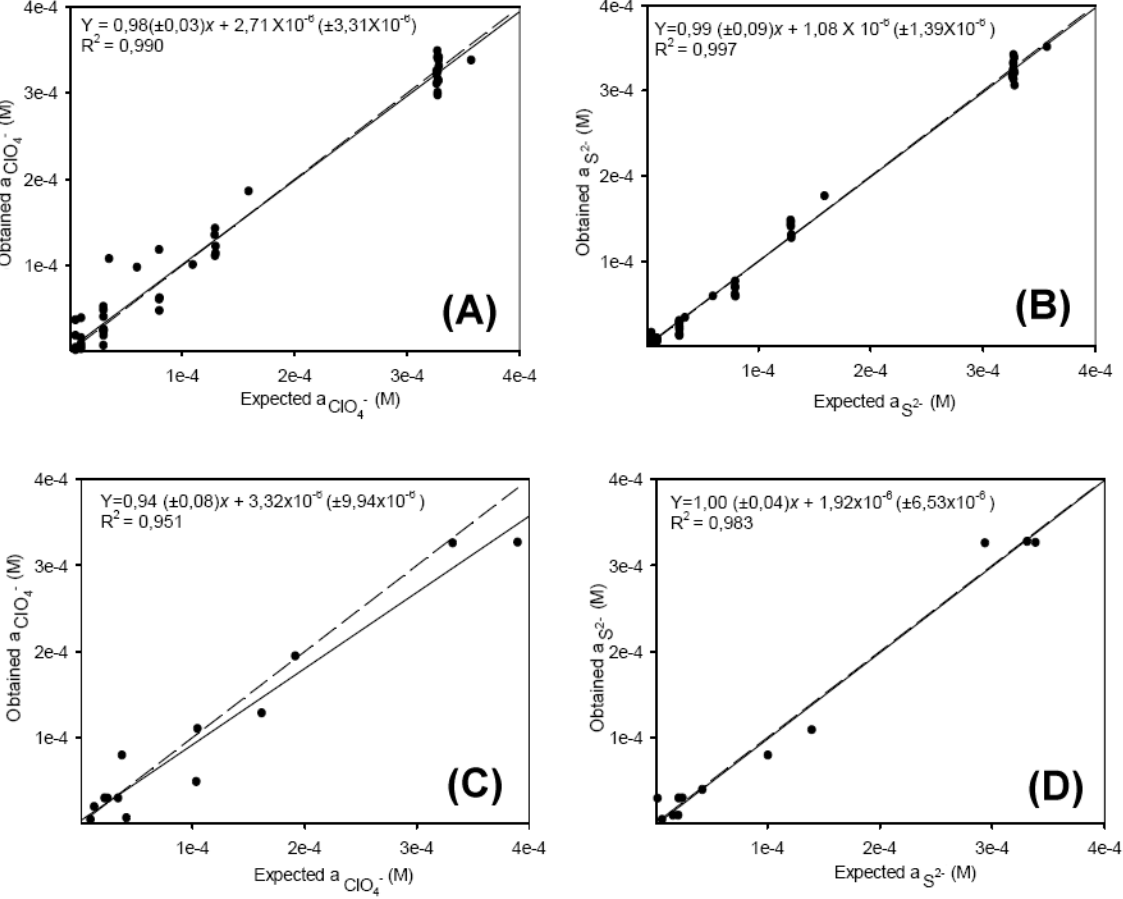
Figure 4. Modeling performance achieved for the optimized ANN with samples from the training test (A,B) and the external test set: (C,D): on the left, perchlorate ion; on the right, sulfide ion. The dashed line corresponds to ideality, and the solid line is the regression of the comparison data. Uncertainty intervals calculated at the 95% confidence